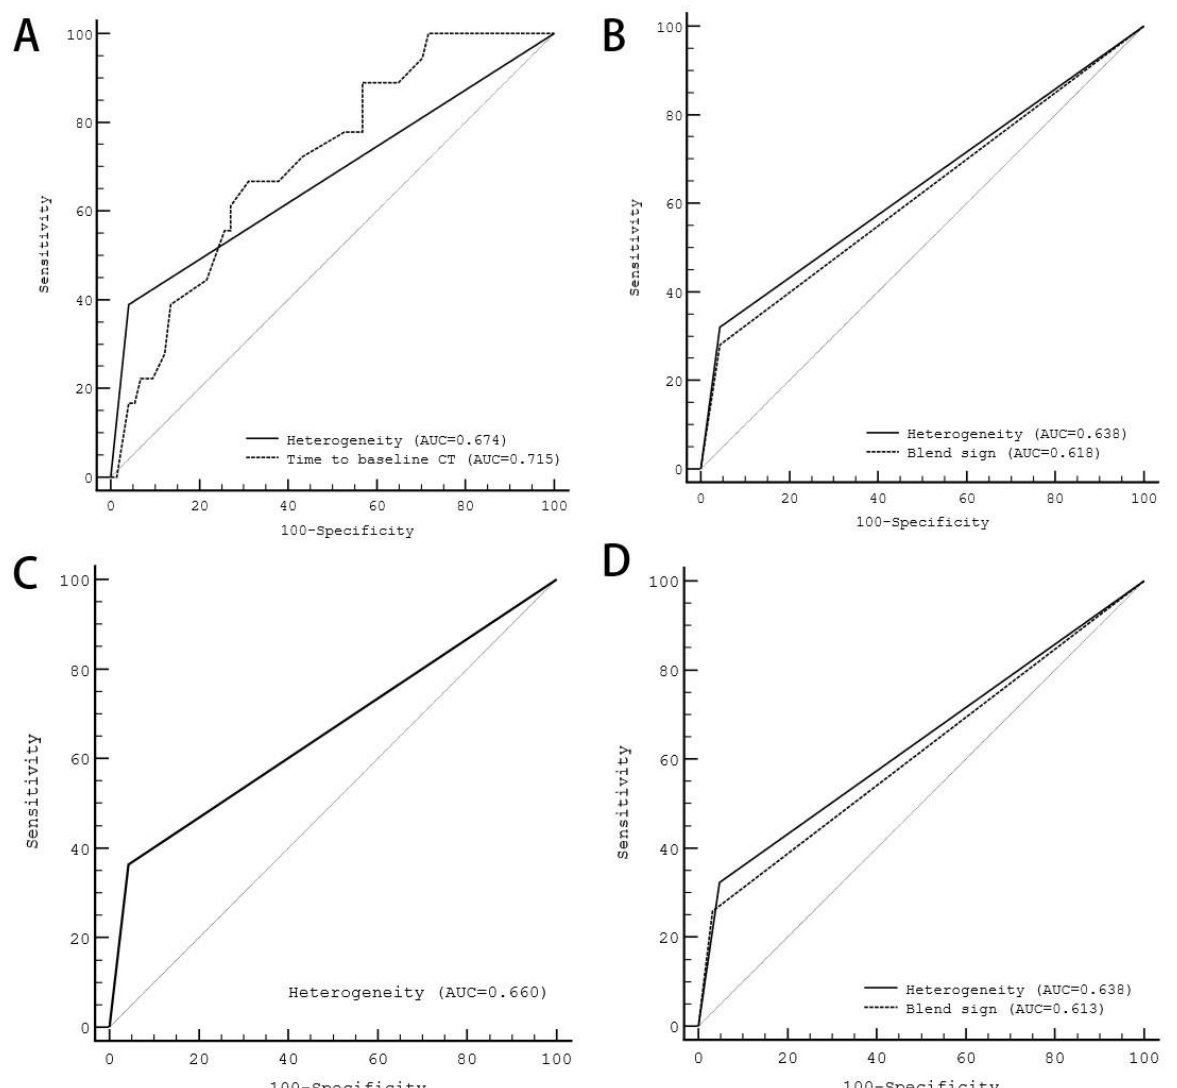
Figure 1. Receiver-operating characteristic curve analysis of significant predictors and different hematoma expansion definitions. ( A ) The AUC of “heterogeneous” was 0.674 ( p = 0.004), and the time to baseline CT was 0.715 ( p = 0.001) in the definition type of BCT within 6 h and FCT within 24 h. ( B ) The AUC of “heterogeneous” was 0.638 ( p = 0.005) and the blend sign was 0.618 ( p = 0.012) in the